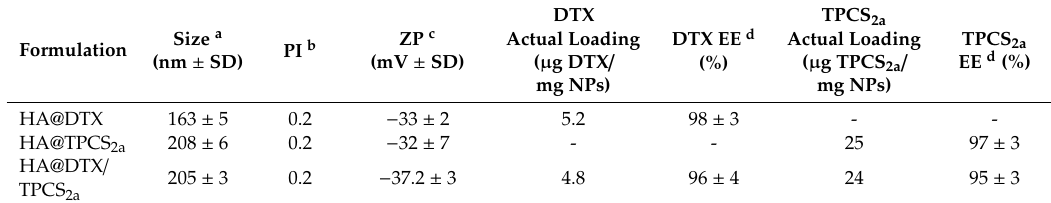
Table 1. Properties of NP formulations a . HA@DTX / TPCS 2a -NPs contain DTX and TPCS 2a in the molar ratio 1:5; for HA@DTX / TPCS 2a -NPs loaded with the drugs in the ratio 1:35 refer to our previous work